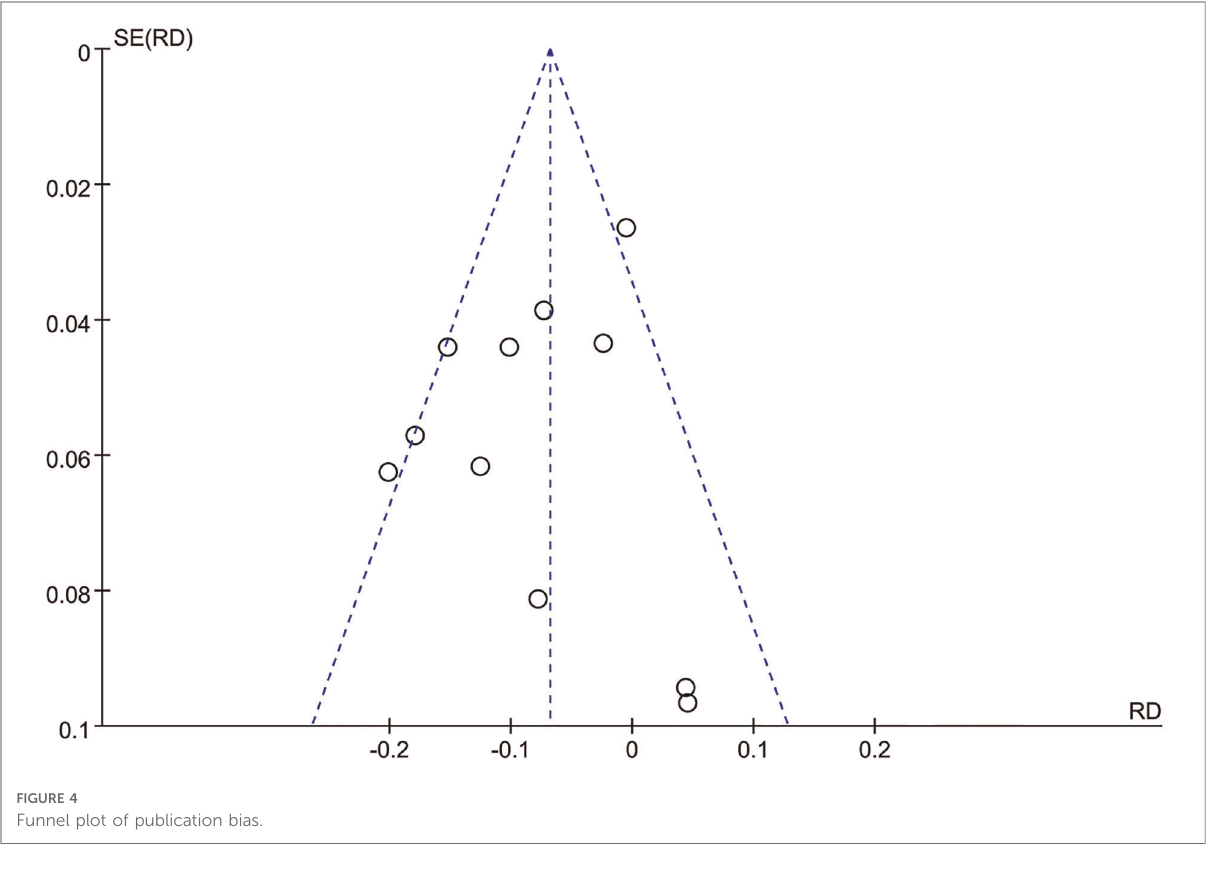
FIGURE 4 Funnel plot of publication bias.